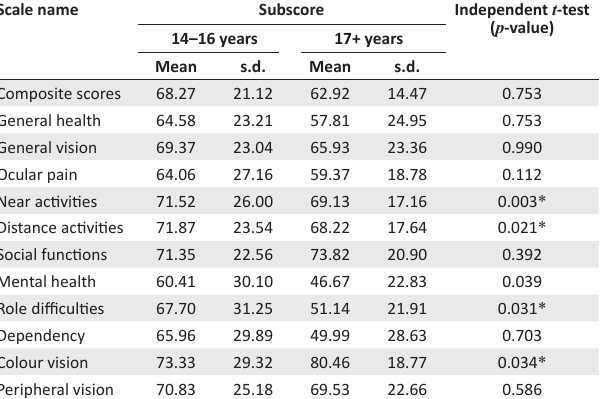
TABLE 4: The mean and standard deviation of subscores of the items on the National Eye Institute Quality of Life Questionnaire-25 for participants with refractive error and visual impairment based on age groups.